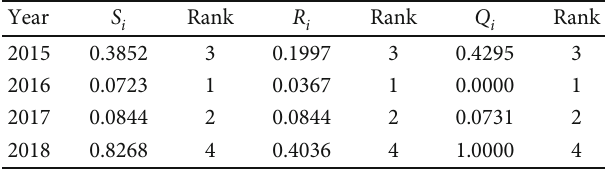
R Q i , i , and i value of the social impact subsystem.